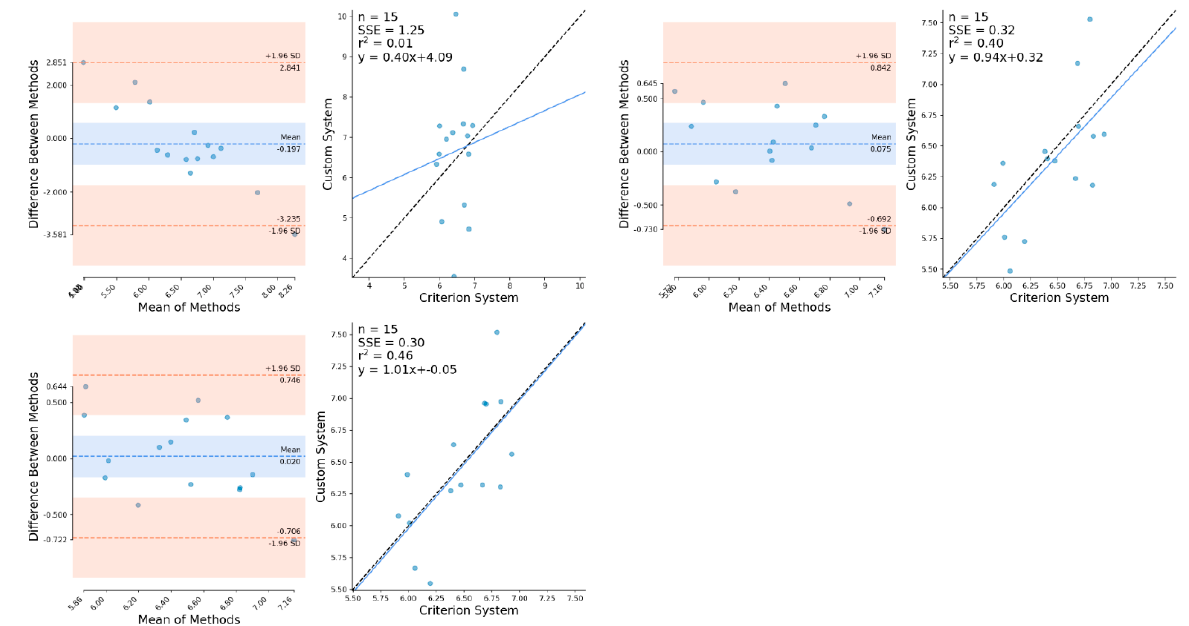
Figure A10. Bland-Altman and linear regression plots demonstrating the differences between OpenPose unfiltered (top- left), low-pass filtered (top-right) and Kalman smoothed (lower-left) CoM horizontal velocity against marker-based CoM horizontal velocity during pushing.